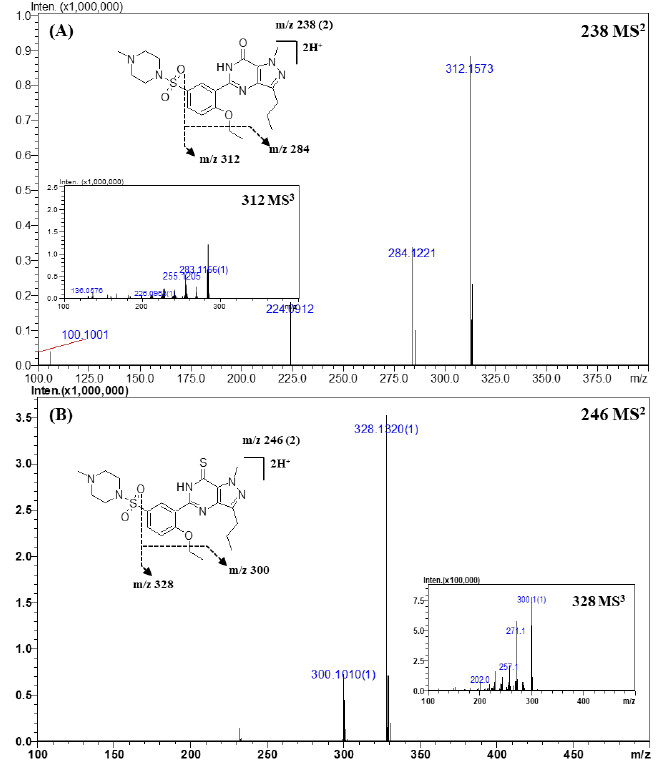
Figure 2. Representative MS n ( n = 2, 3) spectra and proposed fragmentation mechanisms of sildenafil ( A ) and thiosildenafil ( B ). The bracketed numbers next to the m / z values indicate the charge state of the ions.